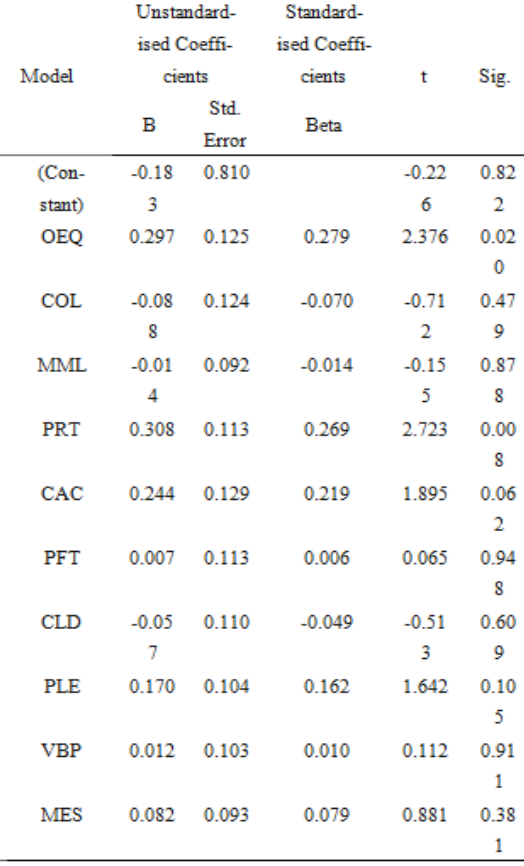
Table 2. The Influence of Teaching Prac